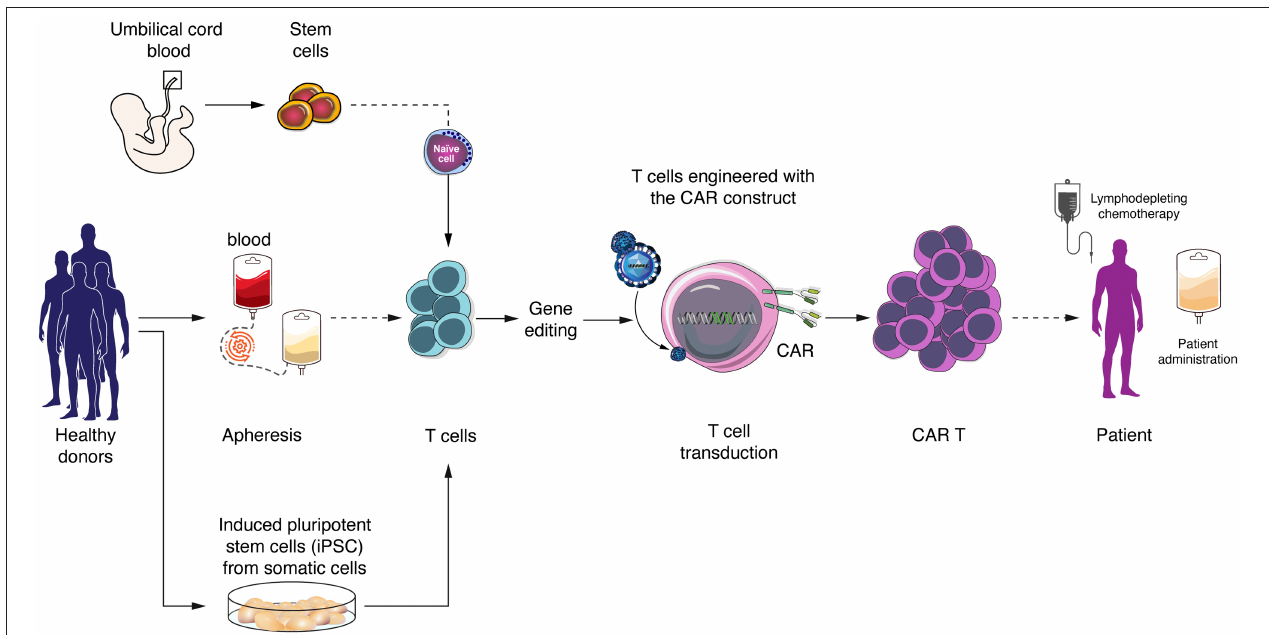
FIGURE 1 | Allogeneic (“off-the-shelf”) CAR T cells generation and sources of T cells. Allogeneic T cells can be obtained from peripheral blood mononuclear cells from healthy donors, umbilical cord blood or derived from induced pluripotent stem cells (iPSCs). CAR T cells are generated by virus transduction and in vitro expansion before patient